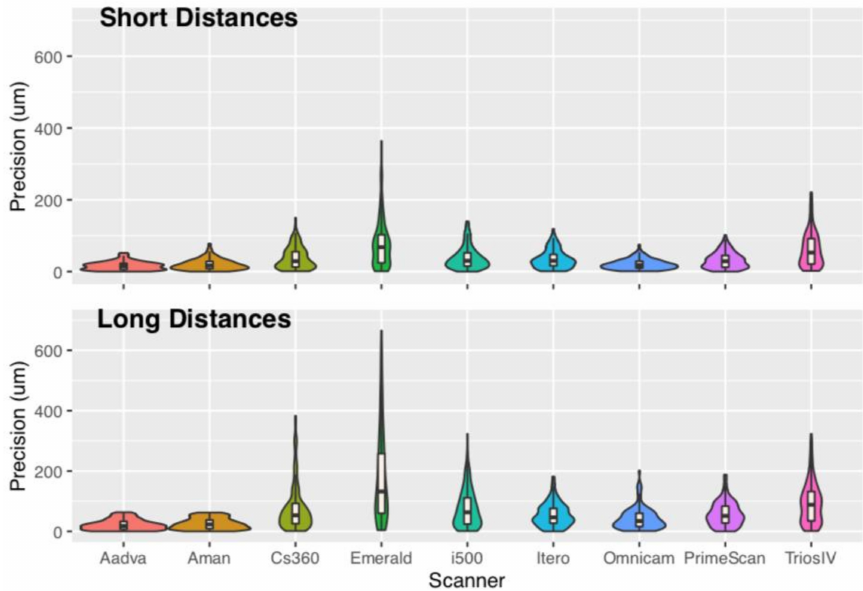
Figure 4. Linear distance mean error and comparison between different digital scanners for